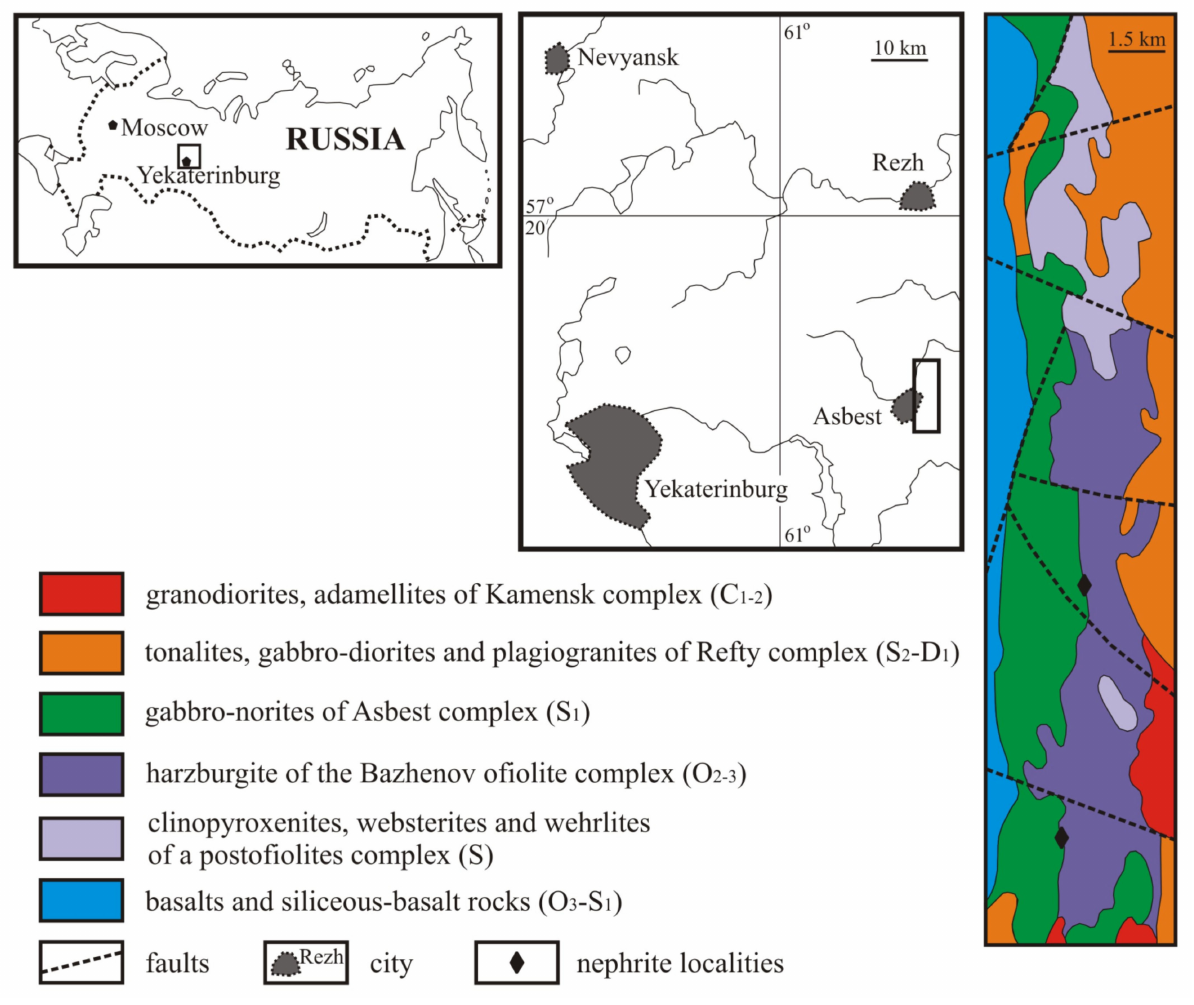
Figure 1. Location and geological map of the Bazhenovskiy ophiolite complex after [10] with our simplifications and